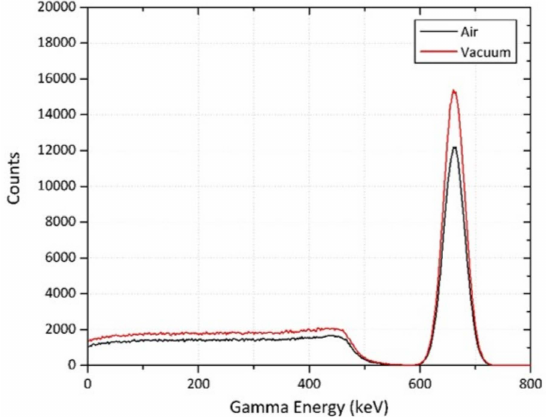
Figure 3. CsI(Na) detector response in “air” and “vacuum”